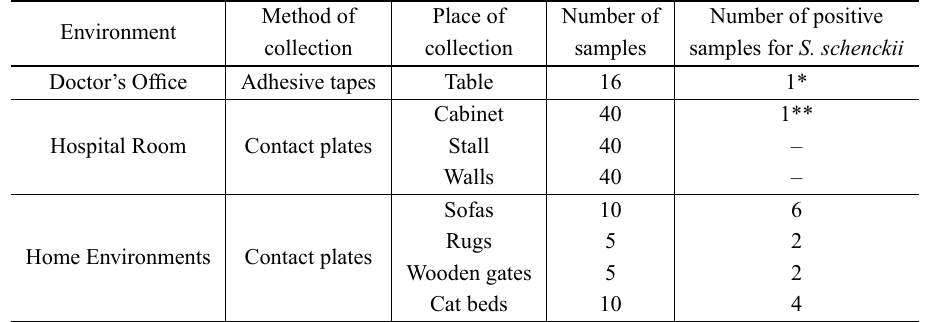
Samples from the doctor’s office and hospital room surfaces obtained in search of S. schenckii .